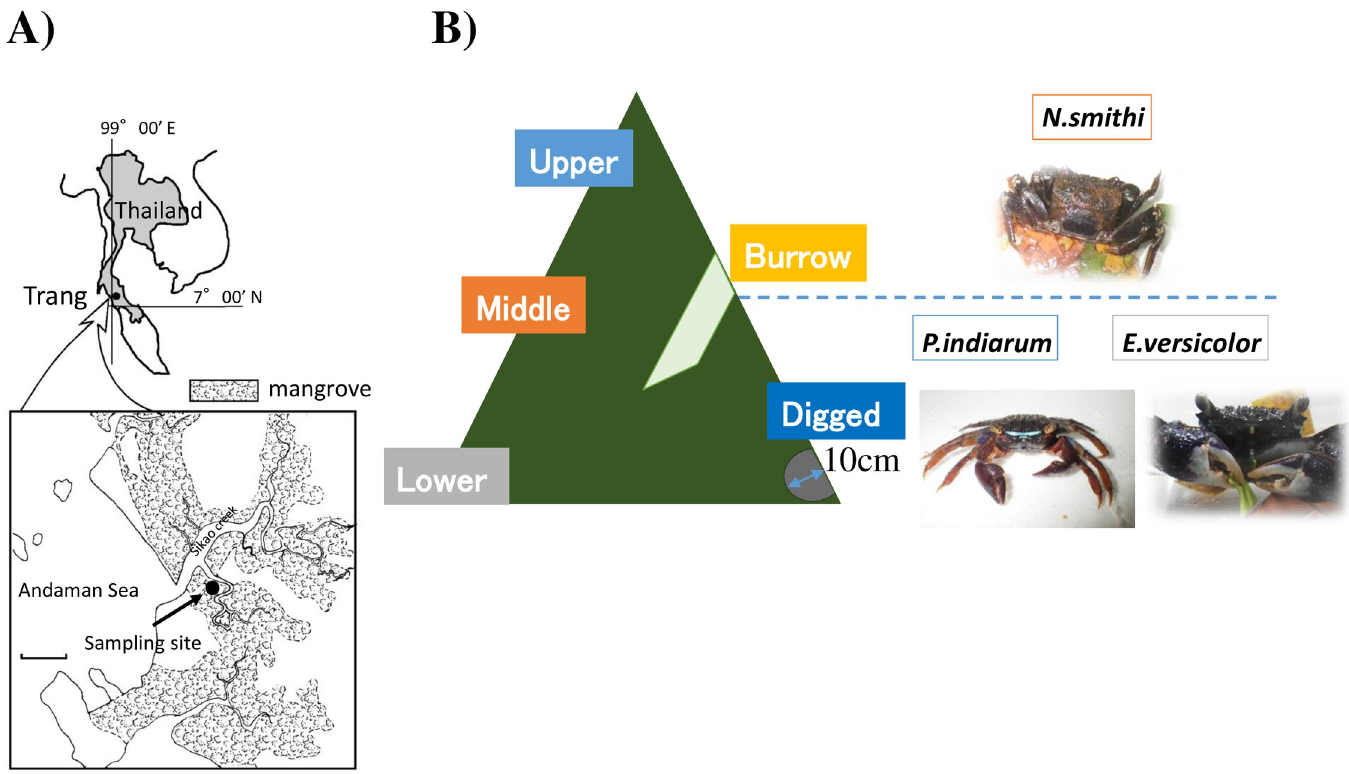
Fig 1. Location of experimental station and sampling points. A) The map of Rajamangala University of Technology Srivijaya, Amphur Sikao. B) Model of the sediment samples. There were four mounds at the station for sediment collection with a height of approximately 100 cm each. Sediment samples were collected from five regions: upper (U1-4), middle (M1-5), lower (L1-5), burrow (B1-3), and dug regions (D1-3). The upper region is completely immersed only during high tide in spring. The lower region is regularly flooded twice a day. N . smithi (NS1-4) were normally found in the middle region of the mound, whereas N . versicolor (NV1-4) and P . indiarum (PI1-4) were found in the lower